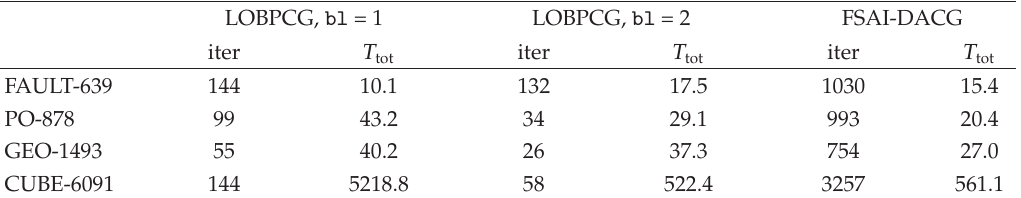
Table 7: Performance of LOBPCG- hypre with Parasails and 16 processors in the computation of the